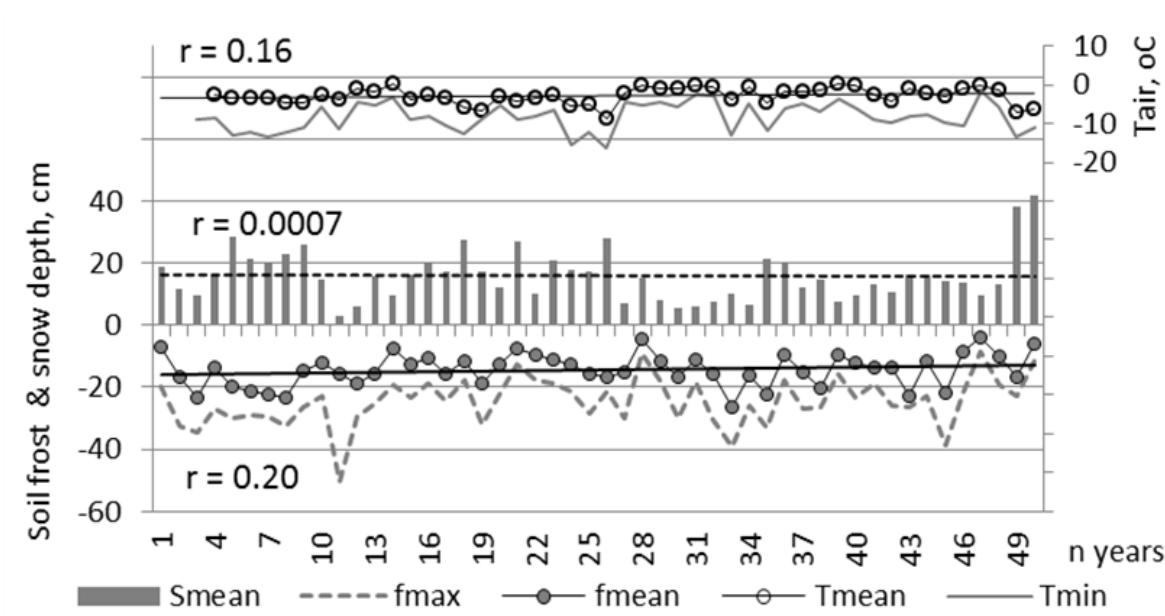
Figure 6. Linear trends of soil frost (f average winter